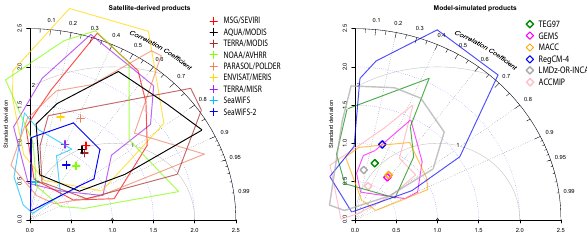
Satellite-derived products